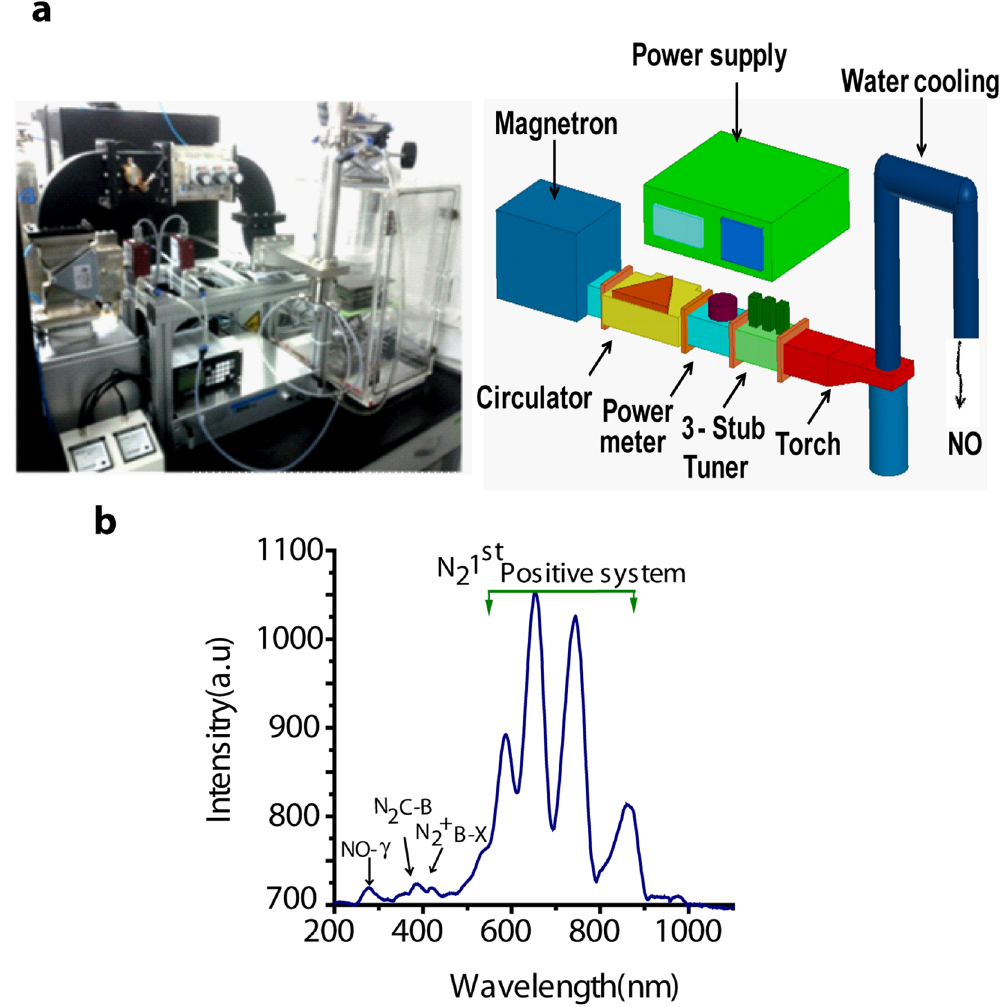
Figure 1. ( a ) Symmetrical diagram of Microwave plasma torch, ( b ) OES spectra of NO production using microwave plasma